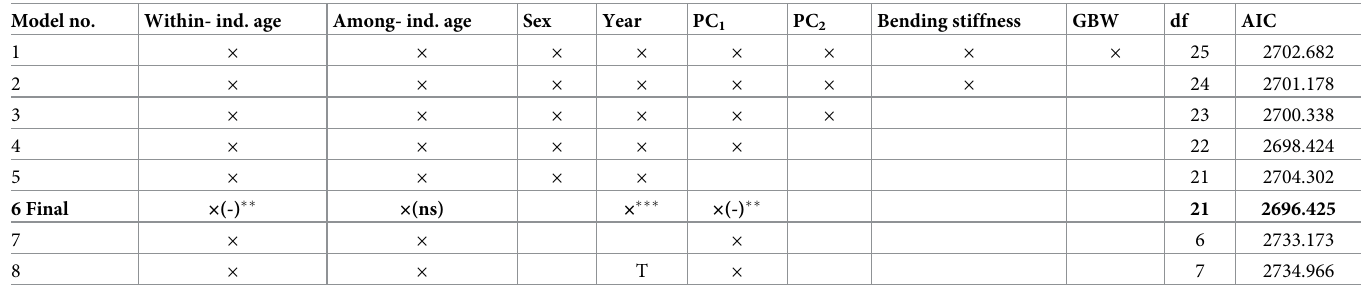
Table 2. Modelling date of Sand Martin capture. Model